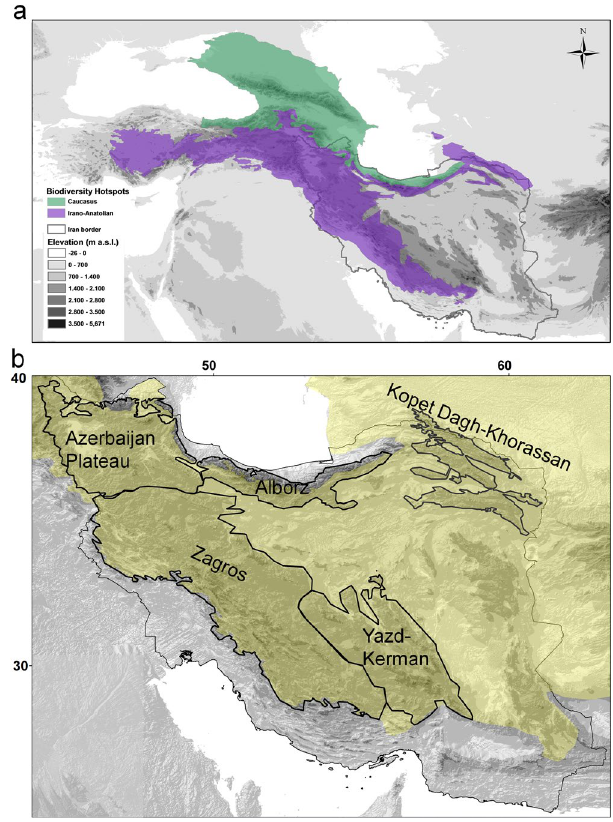
Figure 1. Global biodiversity hotspots, phytogeographic regions and areas of endemism in Iran. ( a ) Topographic map of Iran and adjacent regions showing the Irano-Anatolian and the Caucasus biodiversity hotspots. ( b ) Topographic map of Iran indicating phytogeographical regions (Irano-Turanian region indicated as yellow shaded area, the Saharo-Sindian region and the Euro-Siberian region indicated as unshaded areas south and north, respectively, of the Irano-Turanian region) and areas of endemism, well associated with high mountain ranges of Iran (indicated by outlines and their